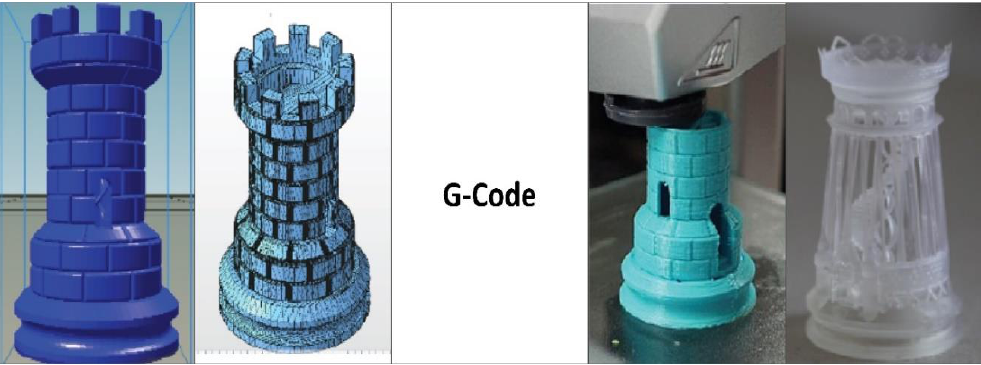
Figure 1. Steps involved in the continuous flow of 3D product fabrication by additive manufacturing technique using G